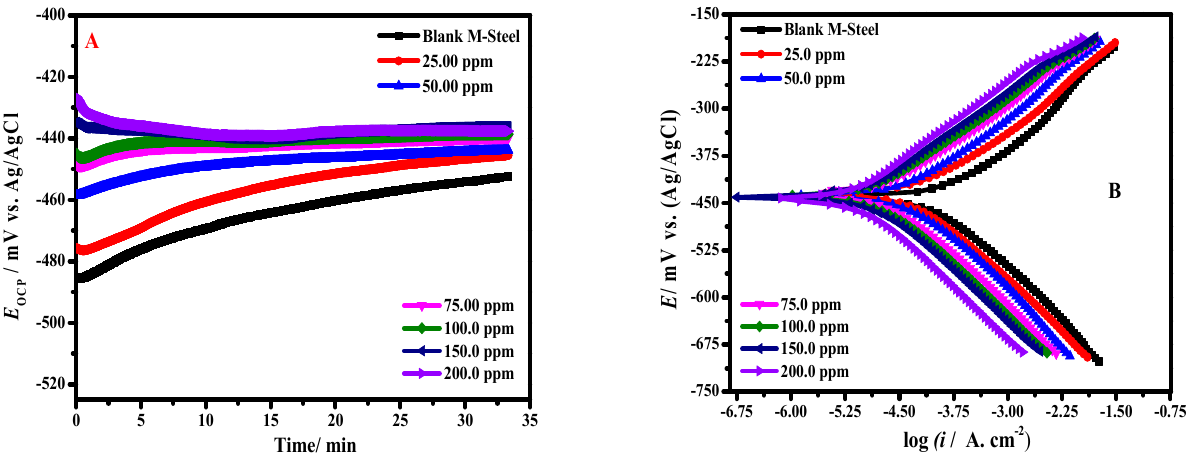
Figure 6. MS alloy open circuit potential vs. time ( A ) and polarization curves ( B ) in blank HCl con- taining brine with six concentrations (blank, 25 mg/L, 50 mg/L, 75 mg/L, 100 mg/L, 150 mg/L, and 200 mg/L) ZnNiO@PANE, and at 298 K.